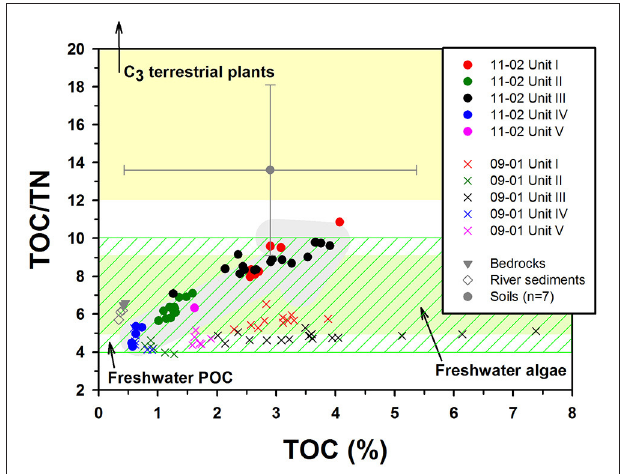
FIGURE 4 | Plot of TOC (%) against TOC/TN, indicating the potential sources of sediments of the Lake Meihua. Units I to V from cores MHL-09-01 and MHL-11-02 are shown. The bedrock (gray triangle), river sediments (gray diamond) and soil data (gray circle with error bar, n = 7) are from Kao and Liu (2000) in the Lanyang River catchment, while the TOC/TN ranges of freshwater algae, freshwater particulate organic carbon (fresh water POC) and C 3 terrestrial plants are from Lamb et al.